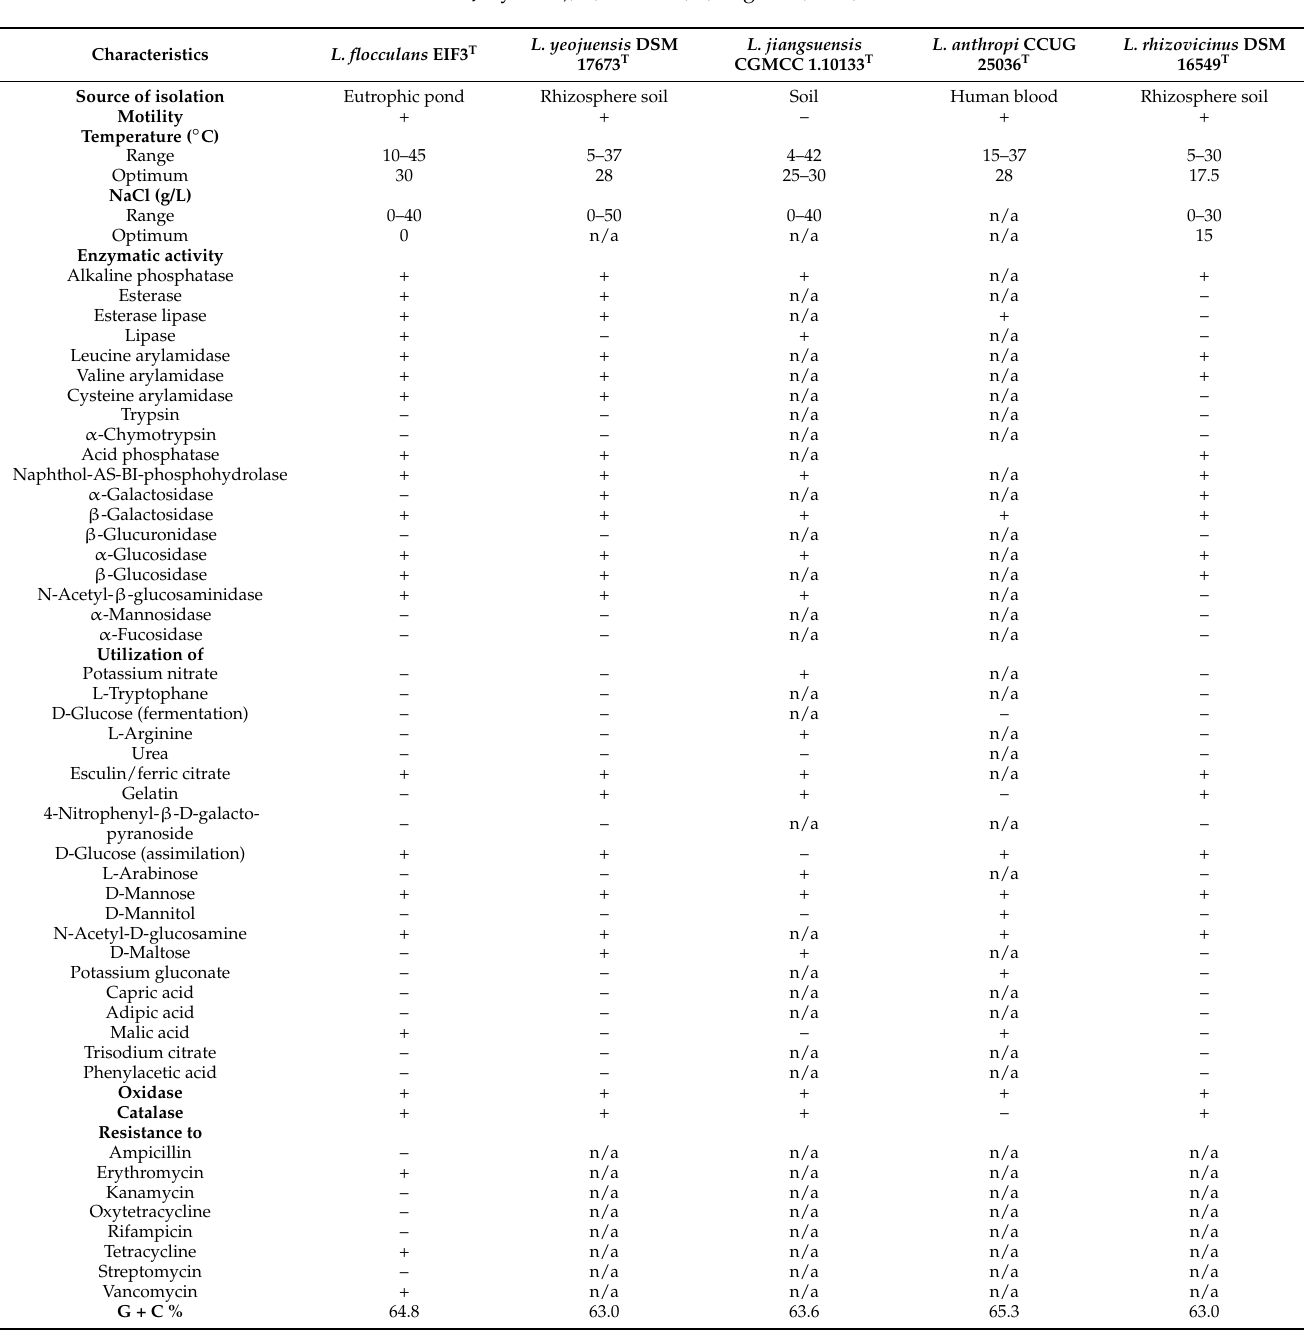
Table 1. Phenotypic differences between strains EIF3 T and phylogenetically related species L.